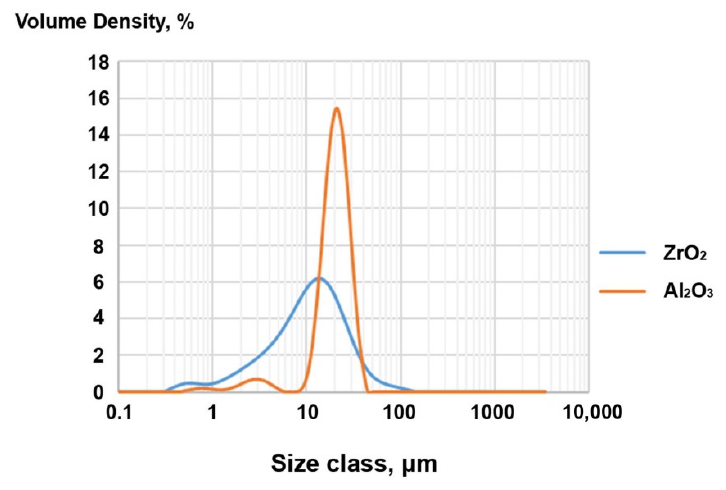
Figure 3. XRD patterns: ( A ) trace of as-received alumina powder, ( B ) trace of 3D-printed alumina composite.